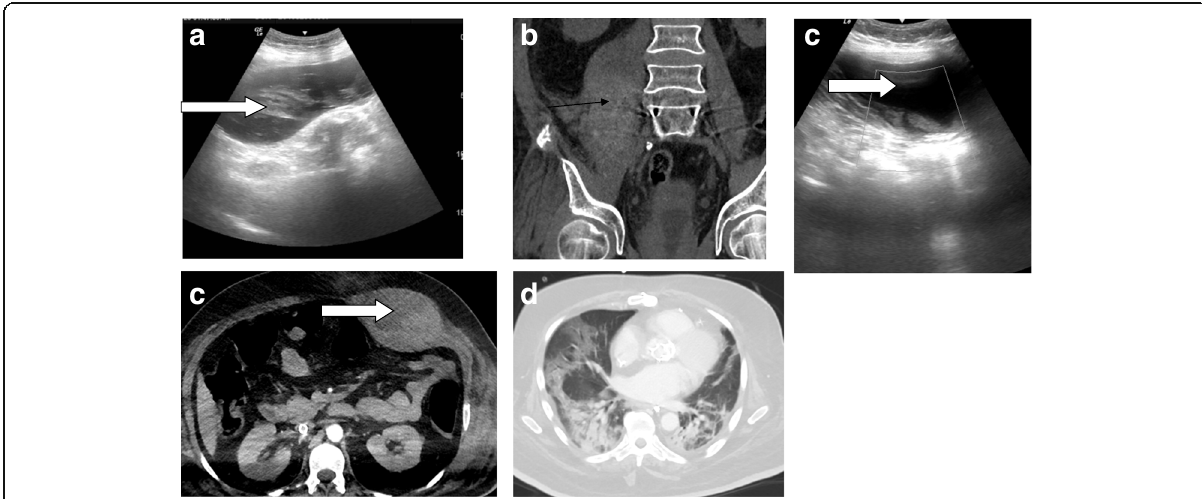
Fig. 3 Two different COVID19 patients with spontaneous hematomas ( a ) sonographic assessment of the right psoas spontaneous hematoma (black arrow in a and b ) in COVID-19 patient with corresponding ( b ) non-contrast CT scan ( c ) left rectus sheath hematoma (white open arrow in c and d ) with ( d ) corresponding CT image in the arterial phase with no contrast extravasation ( e ) basal chest scans in the second patient showing bilateral basal patches of consolidation of COVID-19 pneumonia